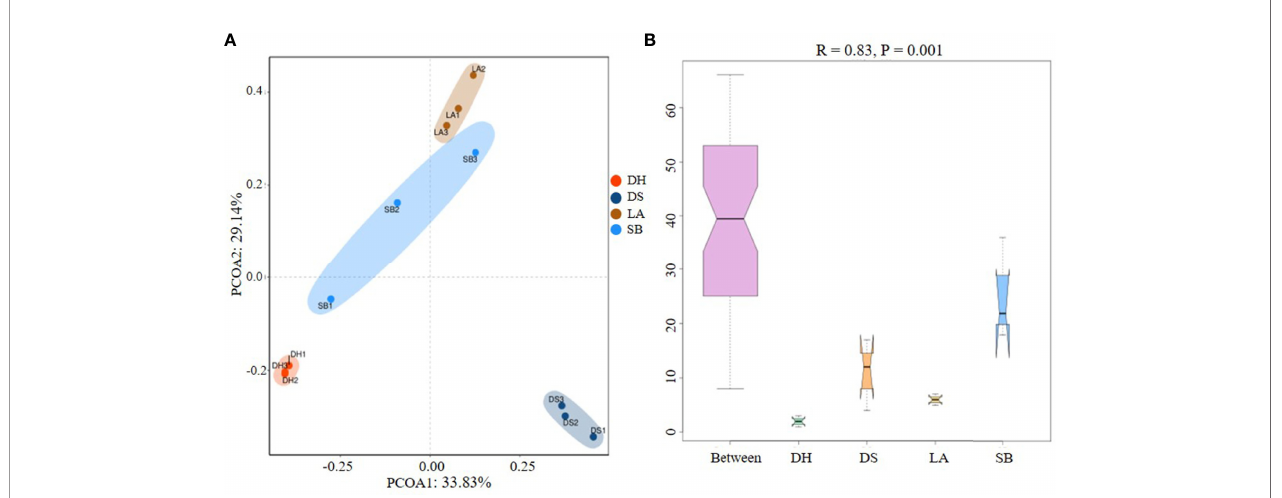
FIGURE 3 | (A) Principal coordinate analysis (PCoA) of intestinal microbes among different pig breeds. Community composition of pig breeds differed at species level, with 33.83% for PCO1 and 29.14% for PCO2. (B) Analysis of similarity (ANOSIM) plots for variations in four groups. Between (all samples), LA, SB, DS, and DH on X-axis represent different groups and numbers on Y-axis represent UniFrac rank. Differences between groups were higher than differences within groups when Between group rank was higher than that of other groups. R-value ranged from -1 to 1, with R > 0 indicating higher intergroup differences than intragroup